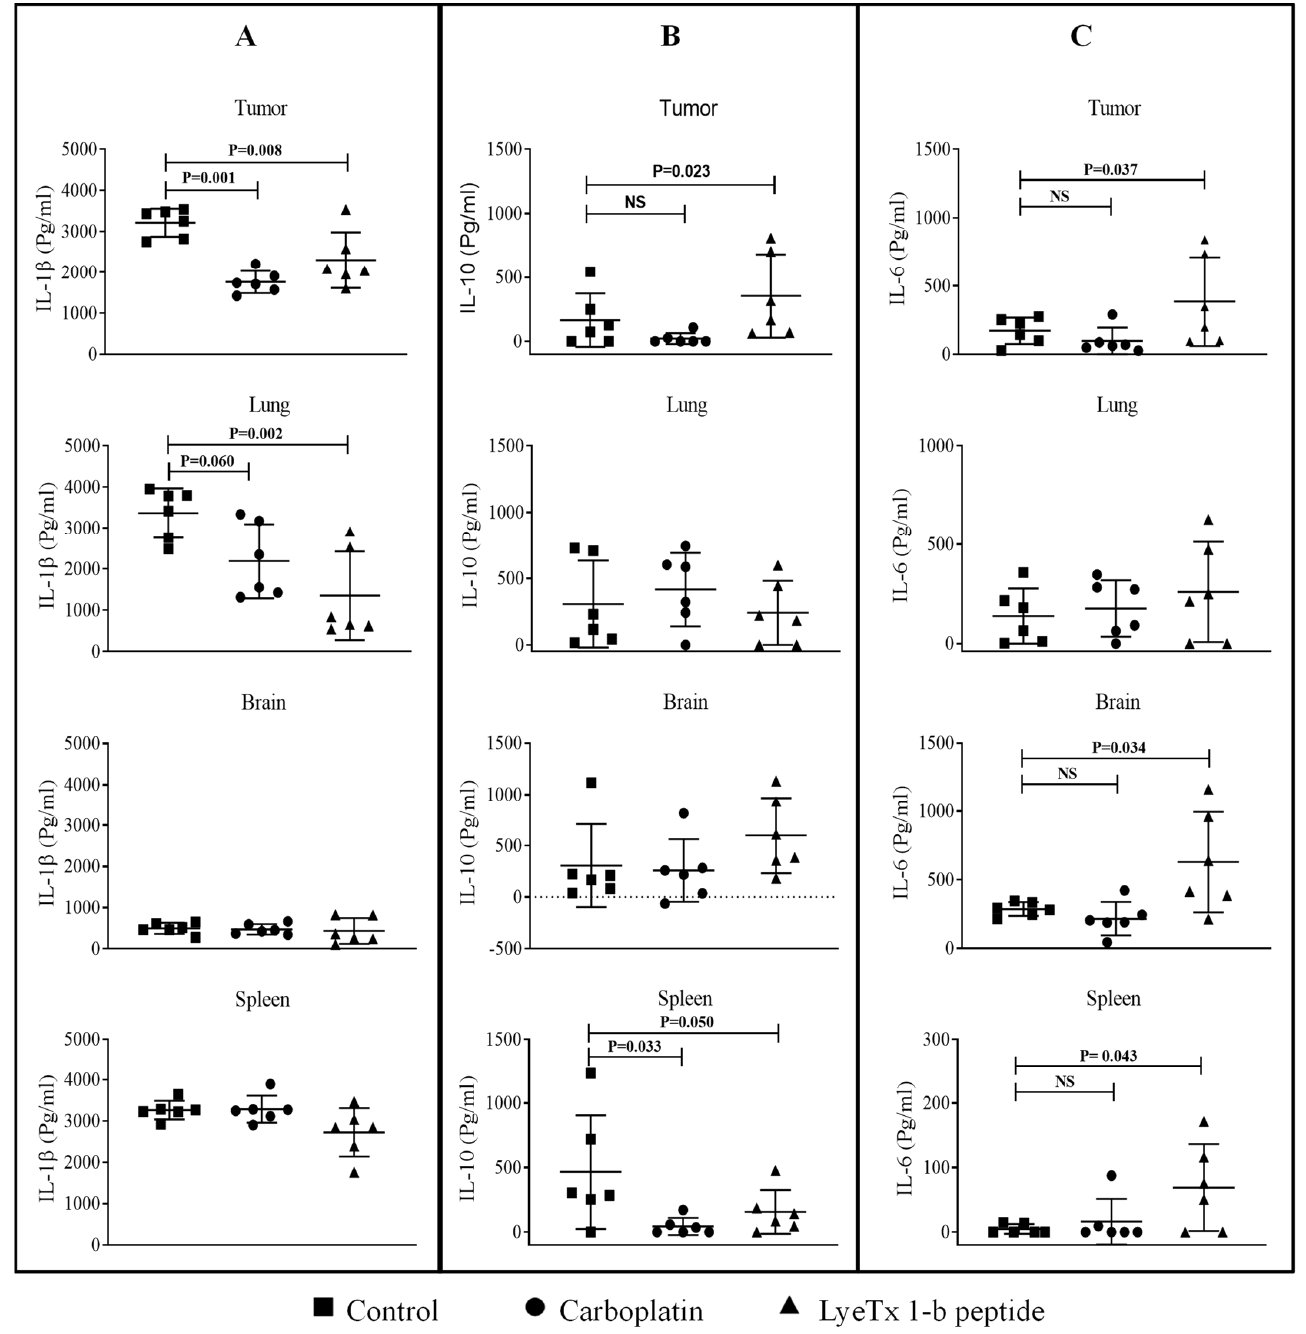
Figure 13. LyeTx I-b changed levels of IL-1 β , IL-6, and IL-10 expression in the tumor microenvironment. Individual values of mice (pg/mL) are presented in a dot plot with an average of each group, n = 6. ( A ) Data correspond to IL-1 β found in the primary tumor, brain, spleen, and lung. ( B , C ) IL-10 and IL-6 levels, respectively. Statistical variation among groups was carried out in 6 animals of each group in duplicate using One-way ANOVA, p < 0.05. NS means not statistically significant.